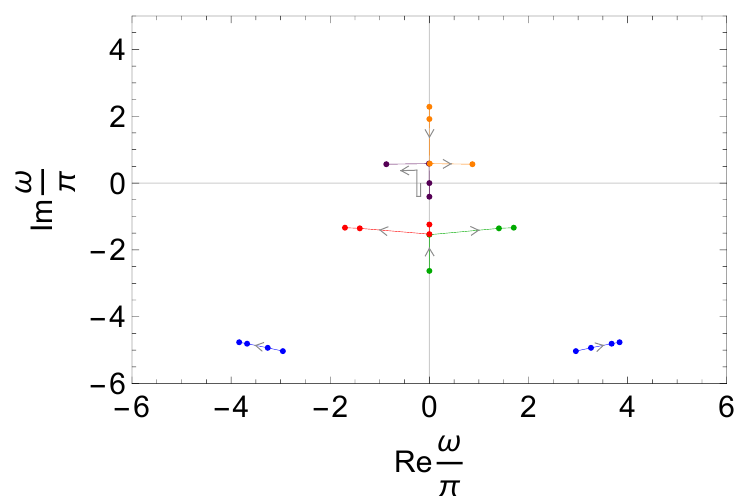
Figure 6 . Behavior of the first six QNMs in complex frequency plane with varying k at ˆ β = 0 . 4 . The arrows indicate the movement of the poles in increasing k , with each colored dot representing k = 0 , k = 1 . 0939 π , k = 1 . 77525 π and k = 2 π respectively. Unlike the cases of ˆ β = 0 . 35 shown